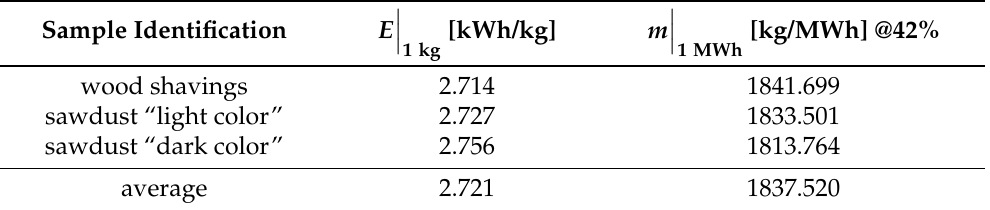
Table 6. Amount of raw material (kg) required to generate 1 MWh of effective energy (considering 42% moisture content).